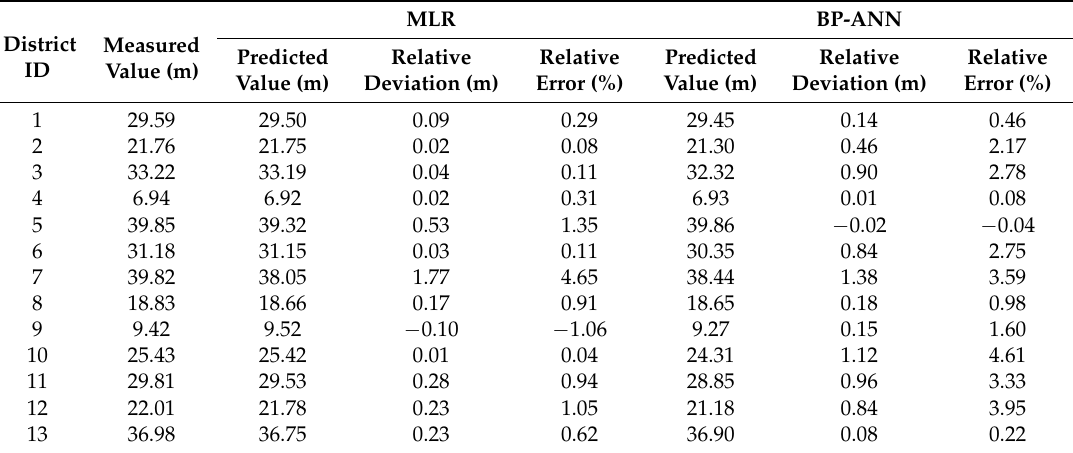
Table 3. Results of the predicted yearly average GWD from the developed models in 2014.